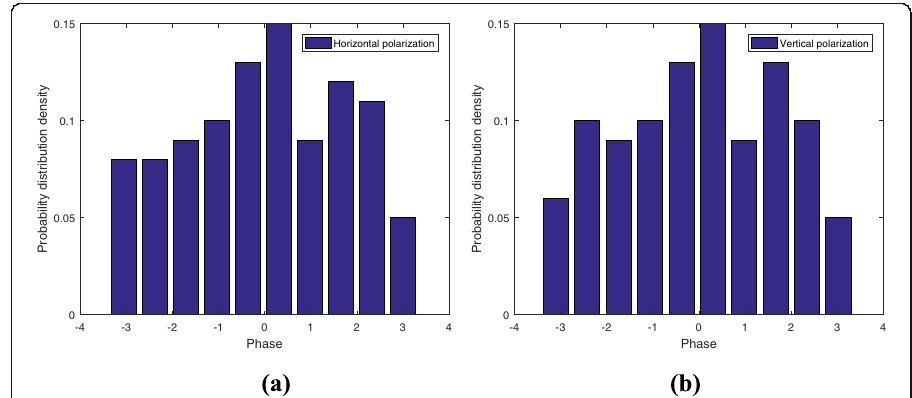
Fig. 5 Phase probability distribution density. a Horizontal polarization. b Vertical polarization